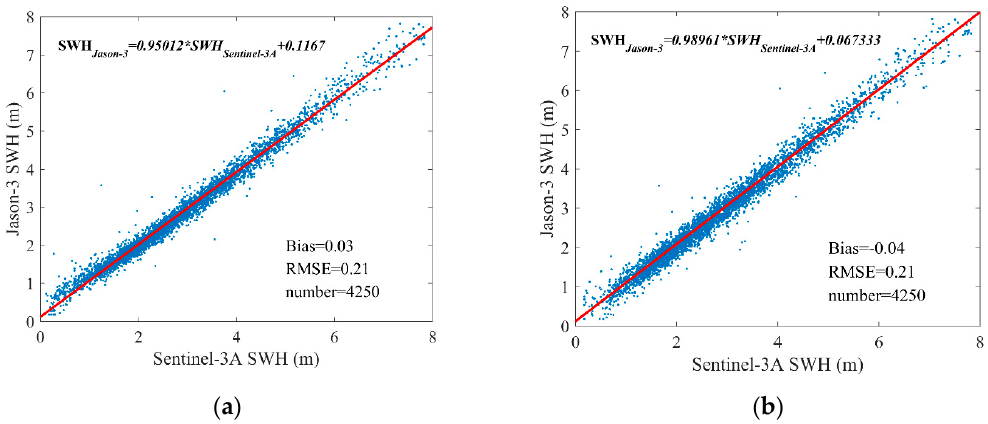
Figure 16. Scatterplots for the SWH comparison between Sentinel-3A ( a ) SAR and ( b ) PLRM modes and Jason-3 at their dual-crossovers.